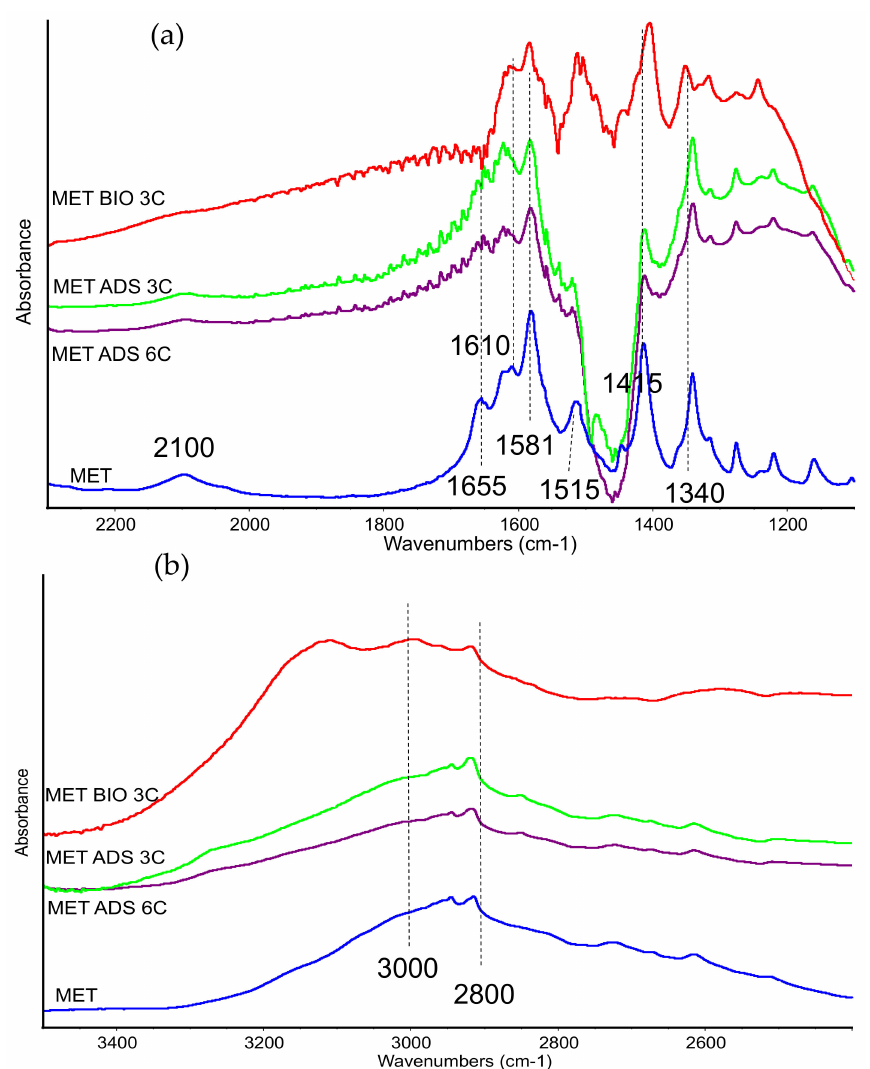
Figure 6. FTIR subtraction spectra (Adsorbene/BioKi + methionine) − (Adsorbene/BioKi) following multiple contacting tests: three steps and six steps. Pure methionine spectrum is also reported as reference: ( a ) low frequency region; ( b ) high-frequency